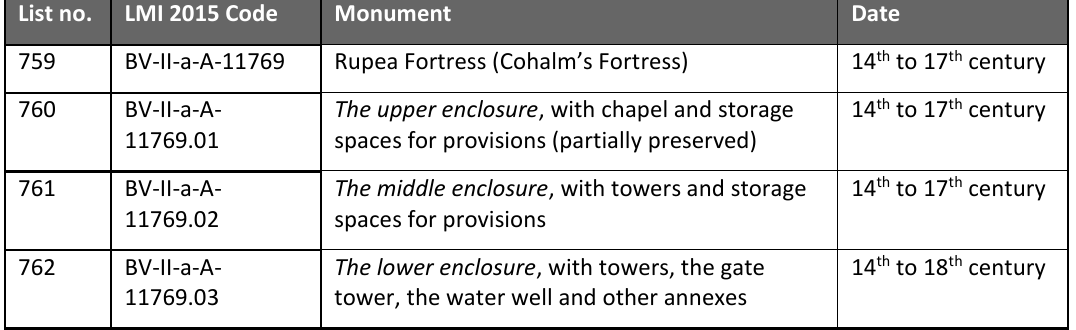
Table 1: Extract from the List of Historical Monuments of Romania, LMI 2015 List